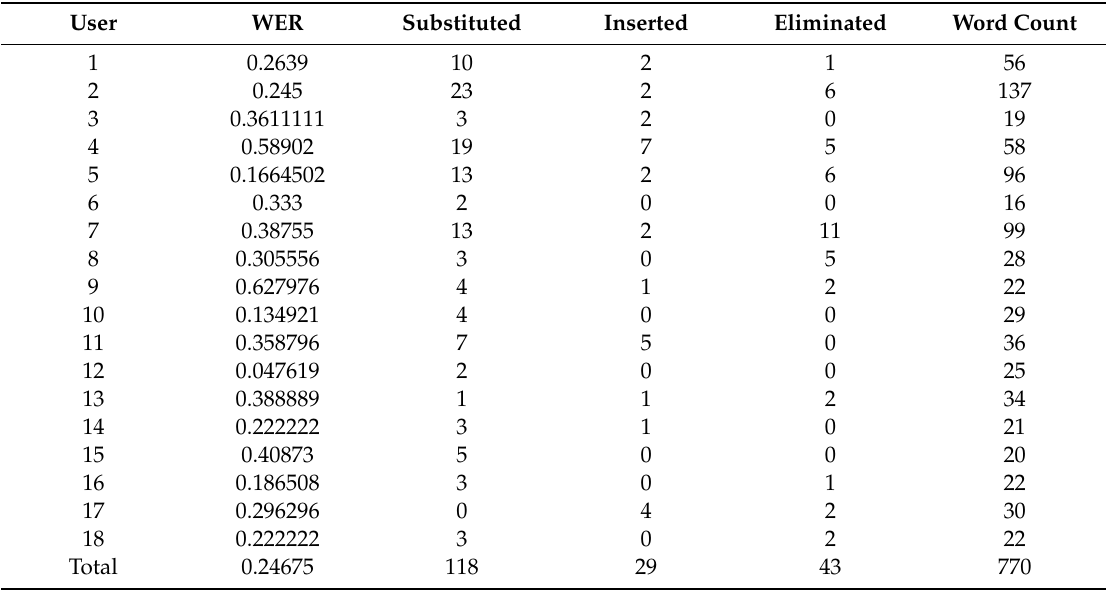
Table1. Speech-to-textworderrorrate(WER)results,